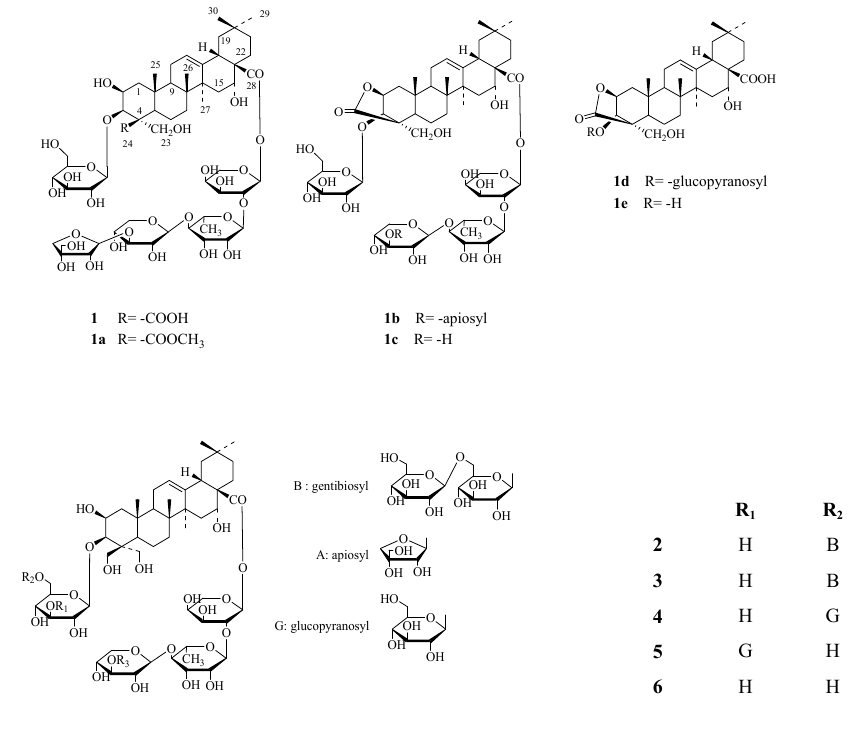
Figure 1 . Compounds 1 - 6 from the root extract of P.